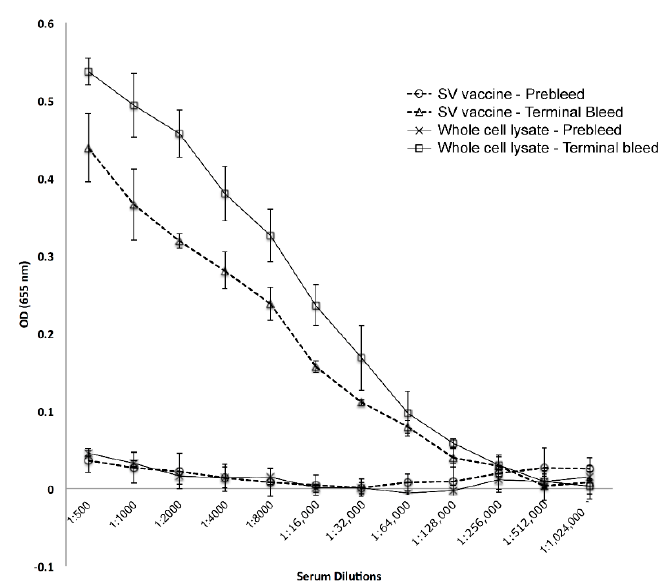
Figure 7. Immunogenicity of SV vaccine and whole cell extracts. BalbC mice were immunized with SVs or whole cell extracts, where the immunizing doses were normalized to 26 µg of protein per immunization. Mice were boosted at three weeks, and terminal blood draws were collected after two addition weeks. Elicited antibody levels were determined by ELISA (total IgG and IgM).